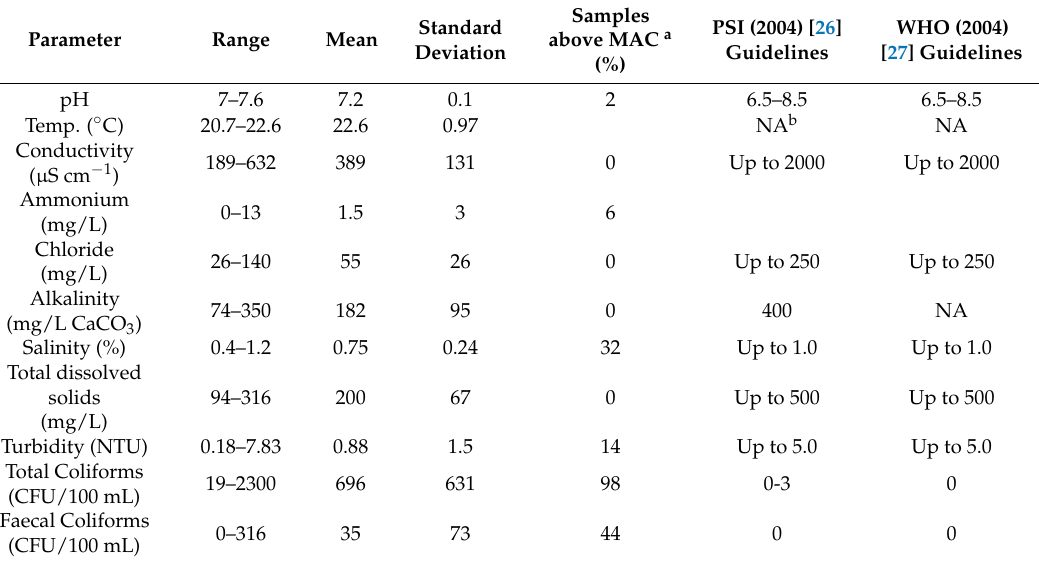
Table 3. Physical, chemical and microbiological characteristics of the rainwater.